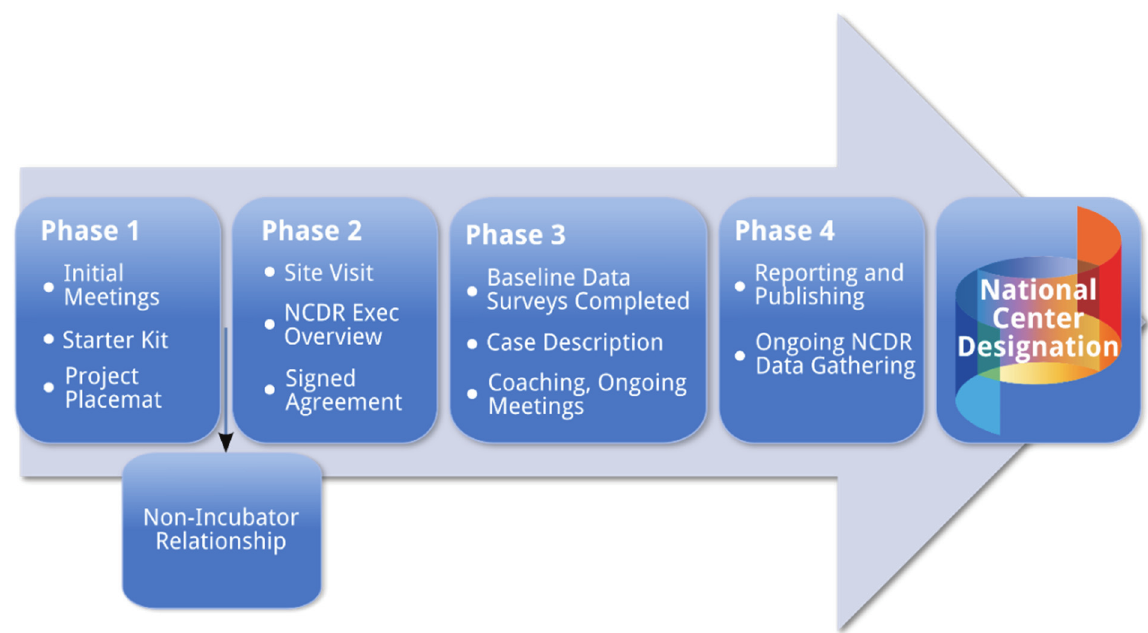
Figure 2. Developmental phases of nexus incubator